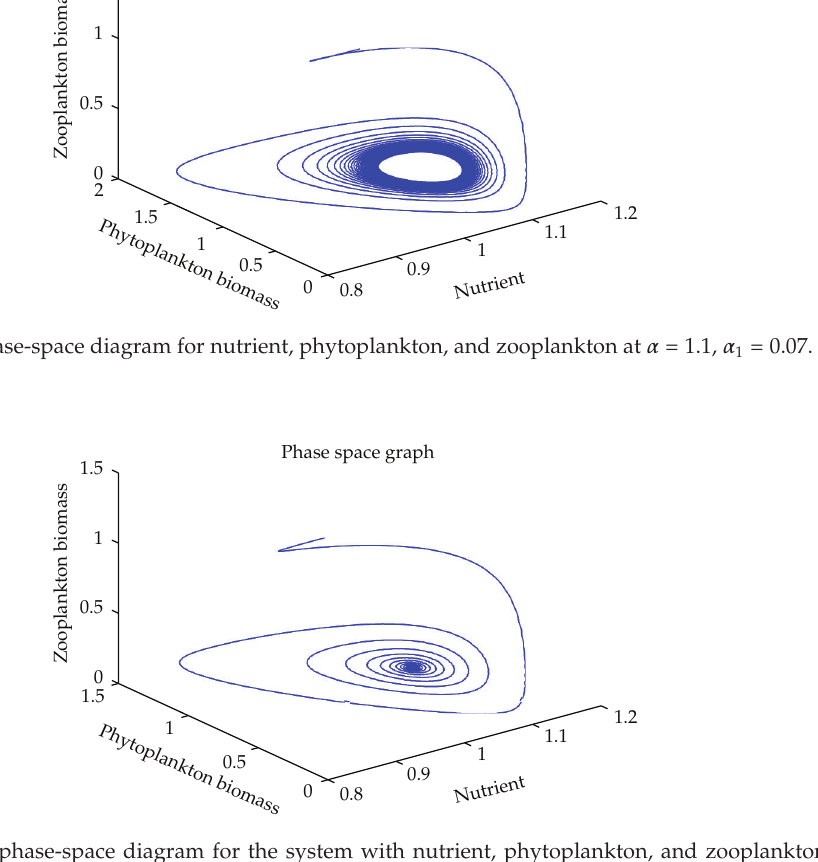
Figure 7: Stable phase-space diagram for the system with nutrient, phytoplankton, and zooplankton at α (cid:7) 1 . 1, α 1 (cid:7) 0 . 12.